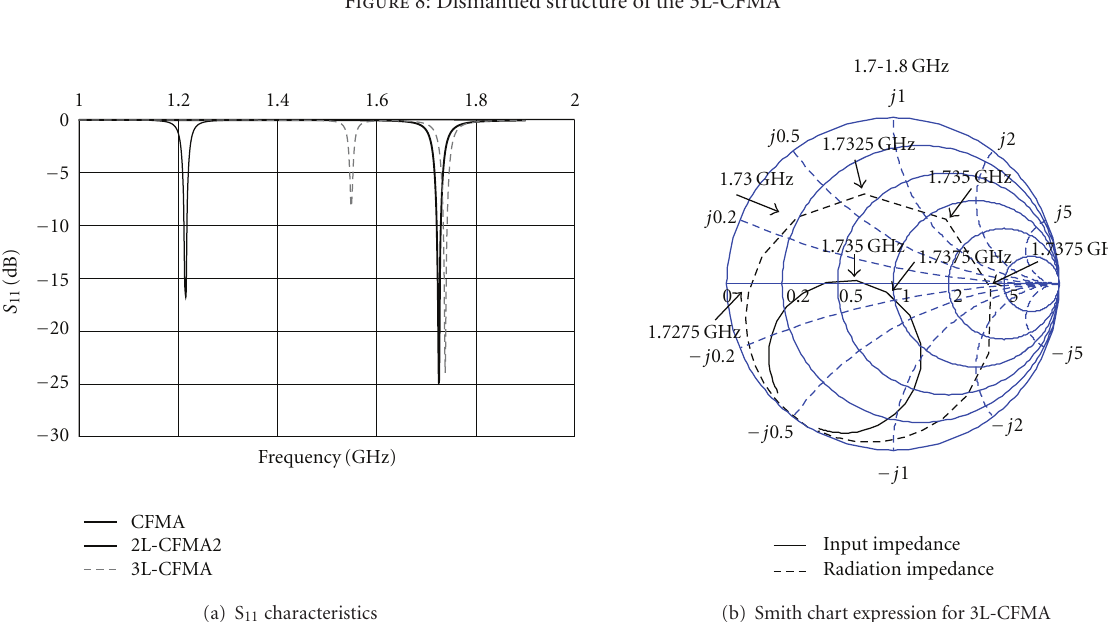
(b) Smith chart expression for 3L-CFMA Figure 9: Simulated input characteristics.